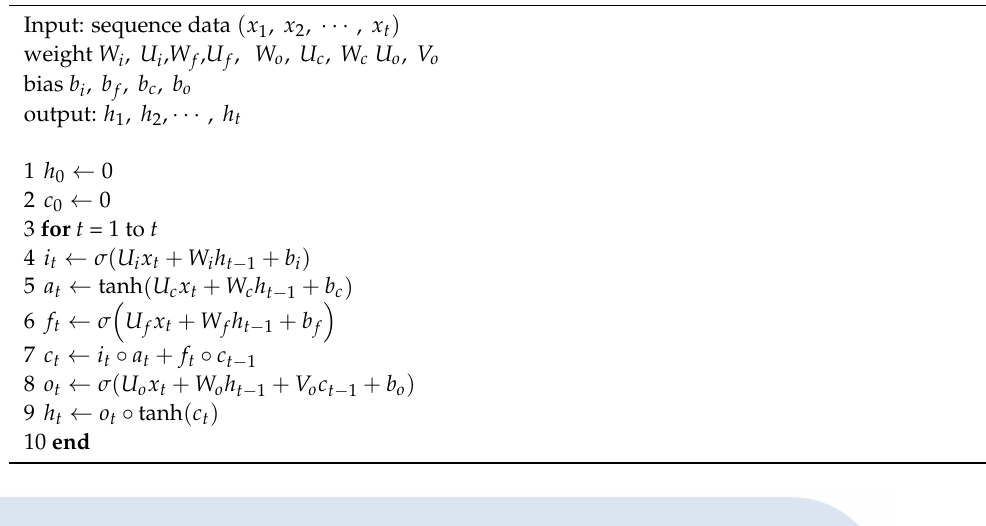
Algorithm 1: Algorithm for execution of LSTM